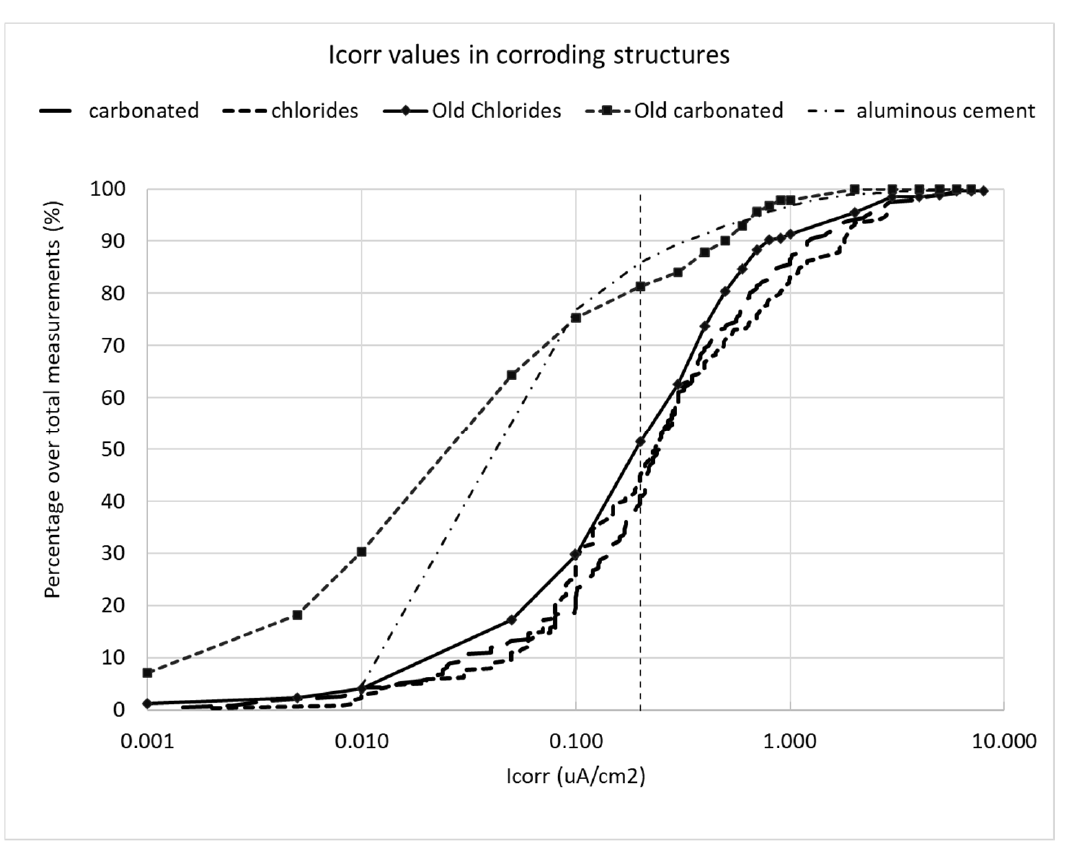
Figure 10. Statistical representation for the values of corrosion rate measured in all kinds of structures (“Old” and “aluminous cement” refer to measurements made by the company Geocisa) [27]. The representation makes it possible to deduce that the structures measured from either carbonated or chloride contaminated, give almost exactly the same statistical distri- bution and they are coincident with the structures contaminated with chlorides measured by Geocisa decades ago, in spite of the very different set of structures inspected. However, the carbonated structures measured by Geocisa (either with aluminous cement or not) give a different distribution that indicates that these structures had a larger number of zones measured which exhibited lower corrosion